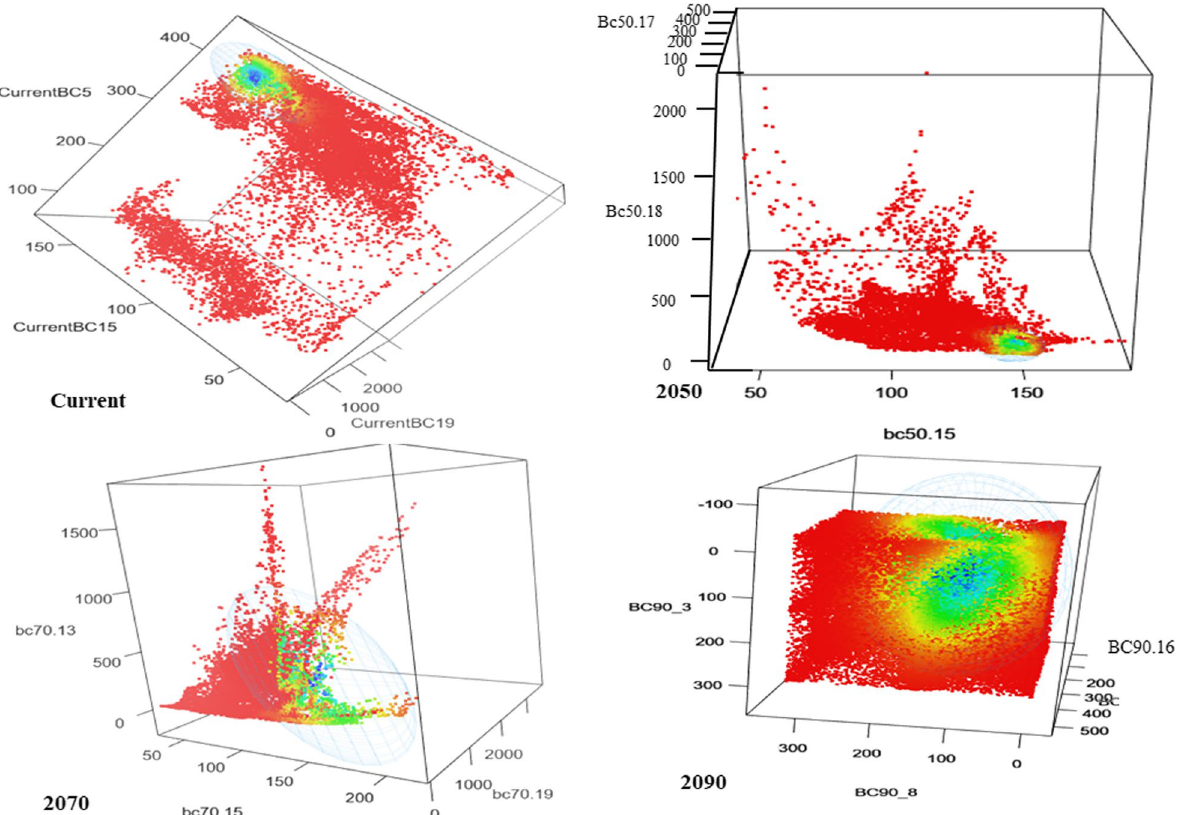
Fig. 12 Graphical representation of C. wightii niche hypervolume with three most influential bioclimatic variables pertains to four climatic projections (current, 2050, 2070 and 2090). The blue colour represents niche stability, the green colour represents niche unfilling (the proportion of the native niche that does not overlap with the exotic niche), and the red colour represents niche expansion